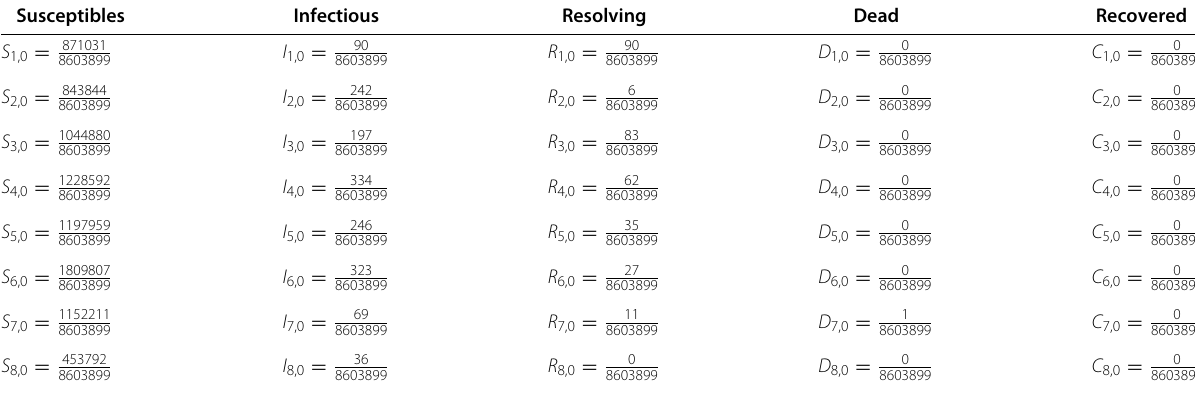
Table 10 Initial values—SIRDC model